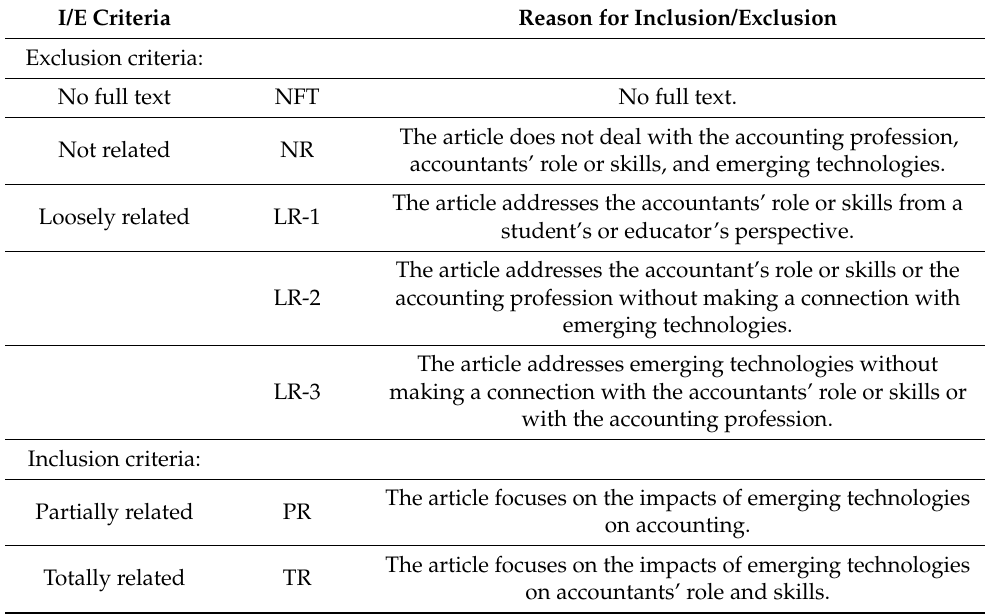
Table 1. Inclusion and exclusion